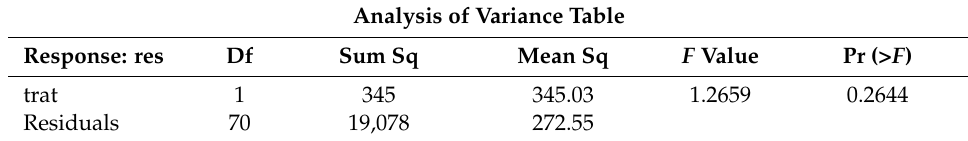
Table A16. R output of ANOVA among the residues generated from the estimation of AGFM using species equation and age specific equation for C 10.